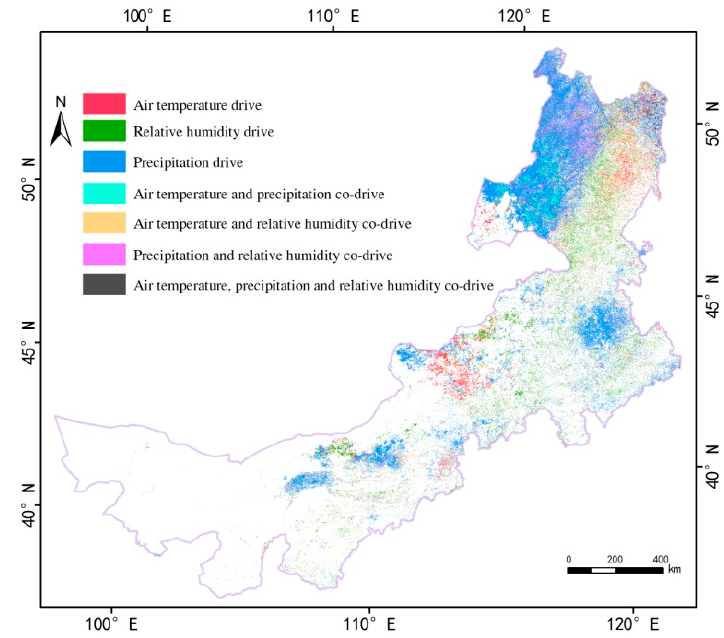
Figure 9. Areas of precipitation drive, air temperature drive, and relative humidity drive in the study area.